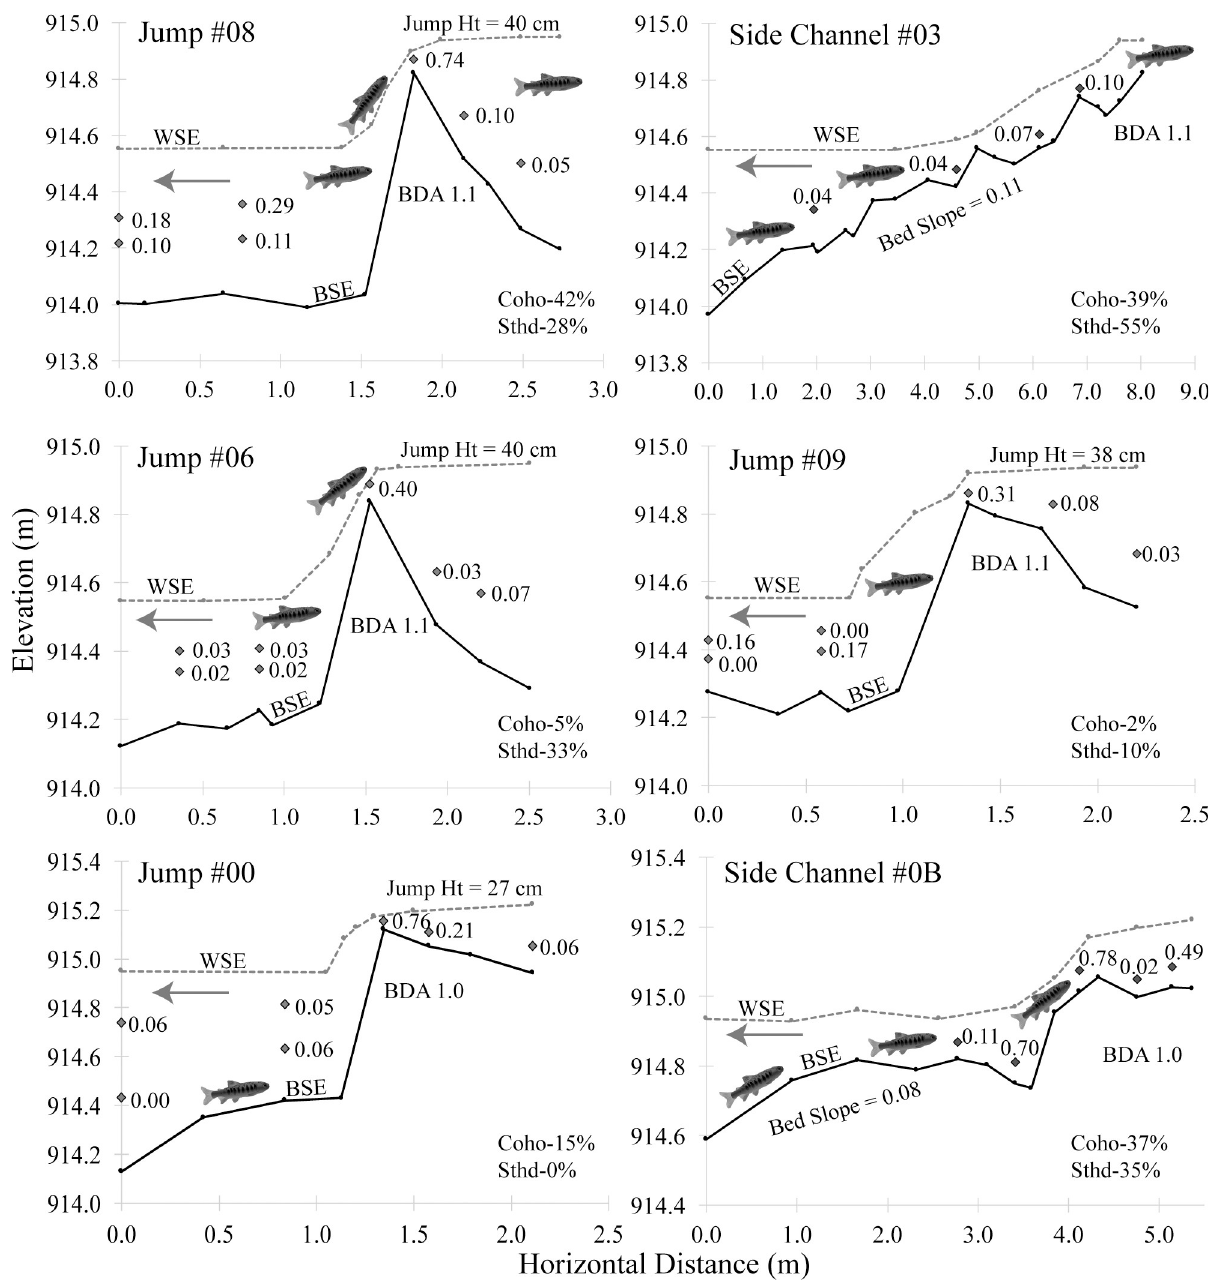
Fig 9. Examples of the local velocities (m/s) experienced by fish as they followed flow paths to cross the beaver dams, along with the percentage of juvenile coho salmon and juvenile steelhead trout that used that route. WSE = water surface elevation, BSE = bed surface elevation. Jump Ht = the difference in water surface elevation (cm) between the pool below a dam and the pool above a dam. The locations of each of the pathways are shown in Figs 2 and 4, with the location number referring to the antenna number placed at that location (e.g., Jump #5 is at the location of Antenna A-5). Blue arrows indicate direction of